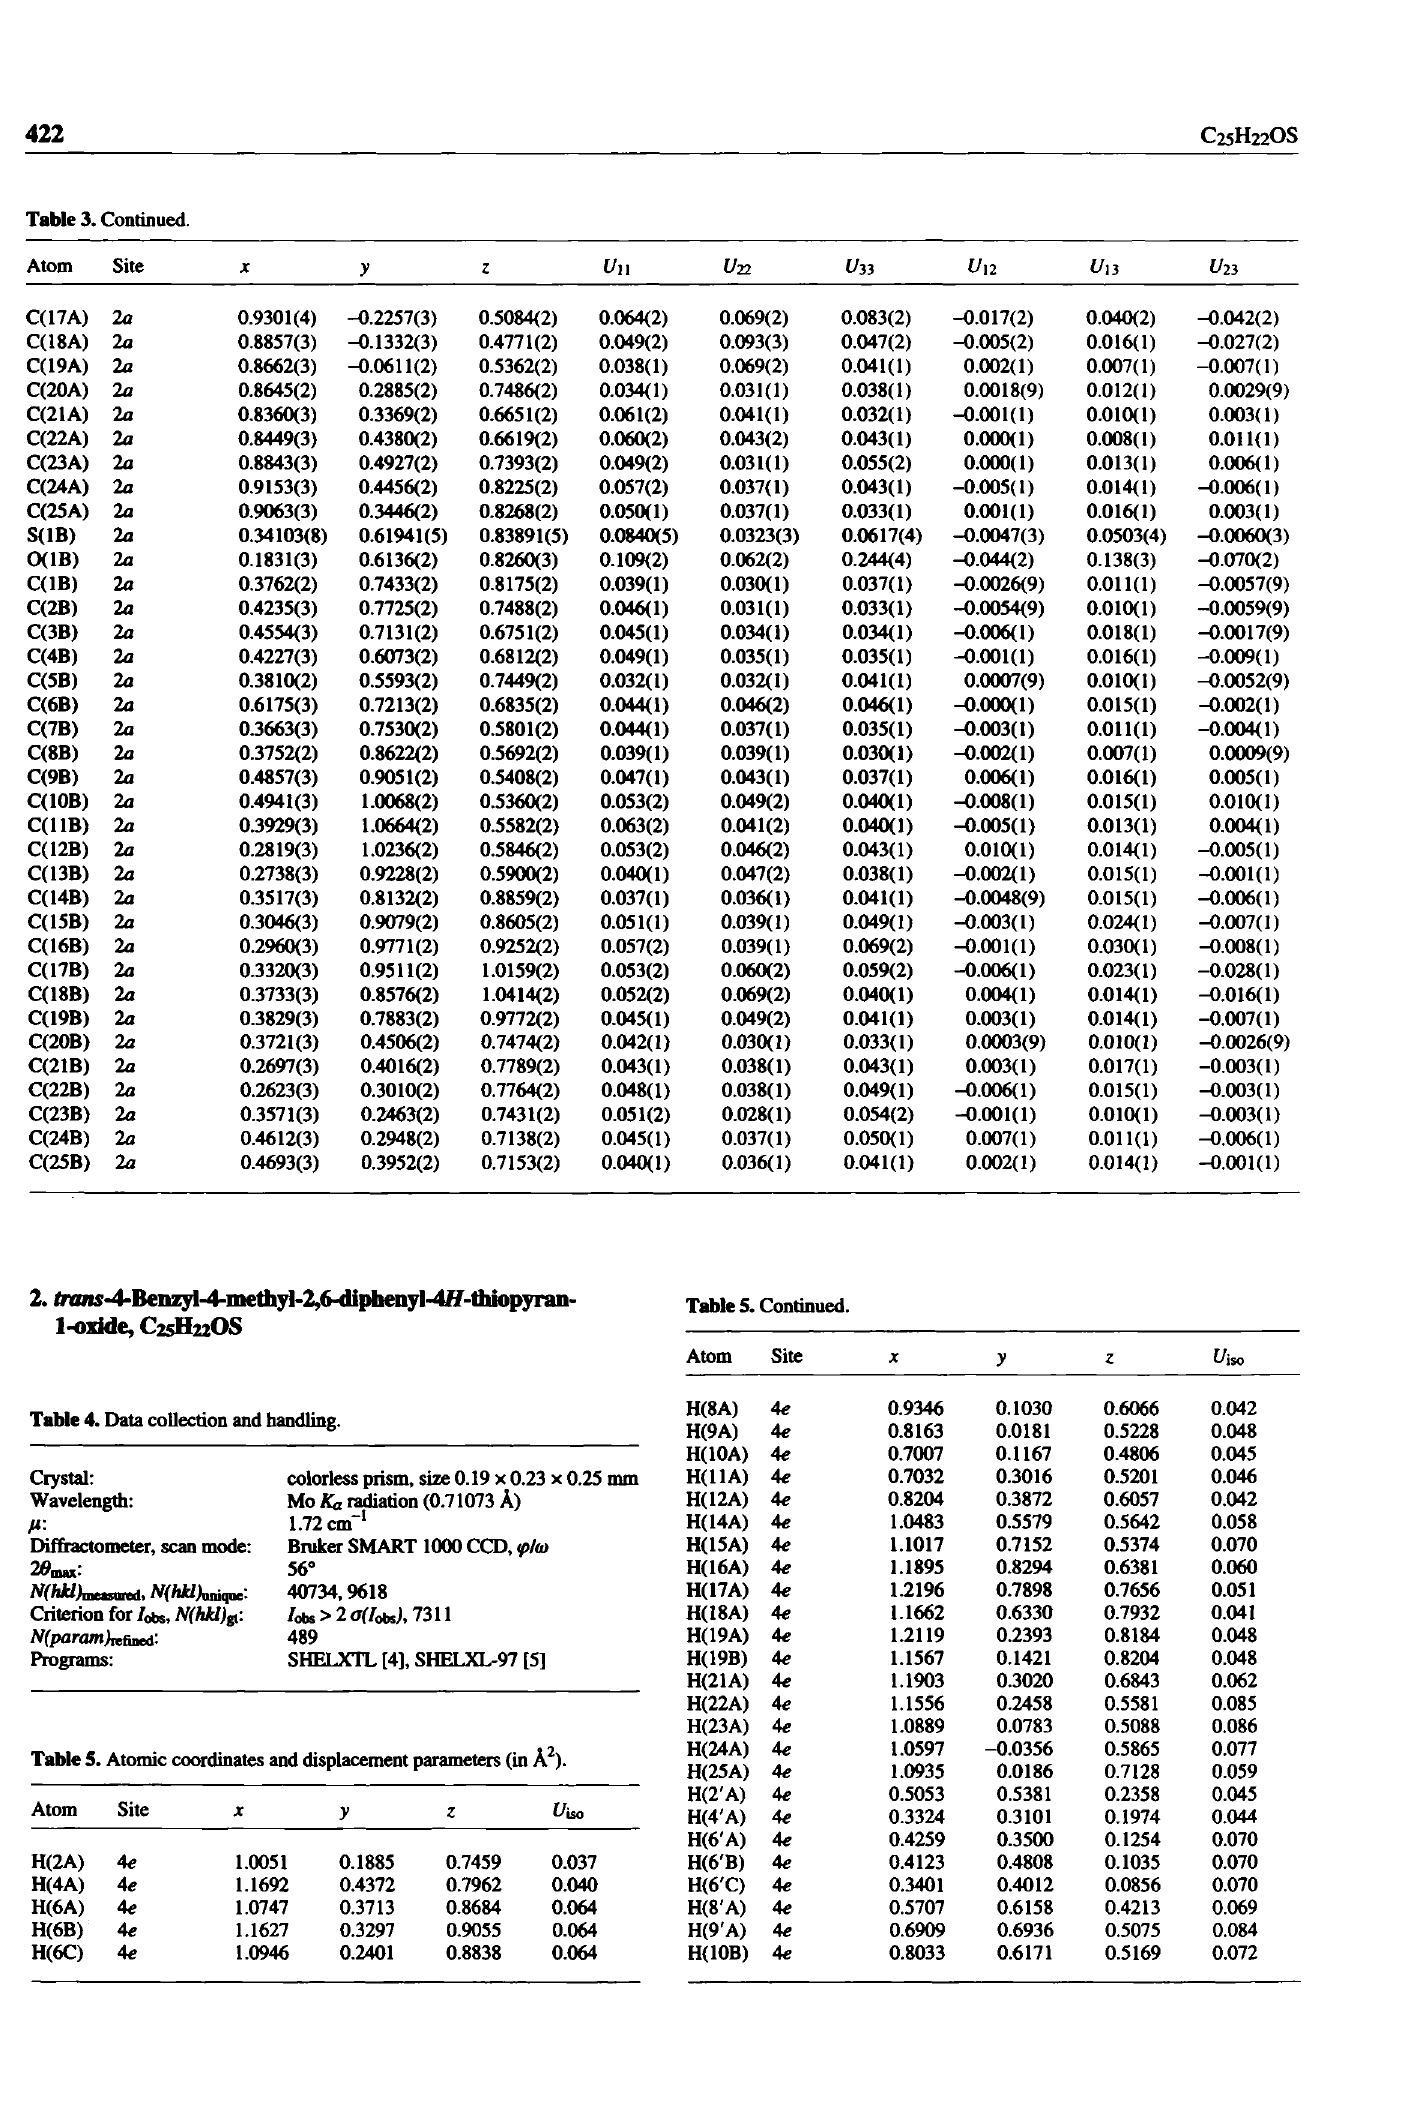
Table 4. Data collection and handling.